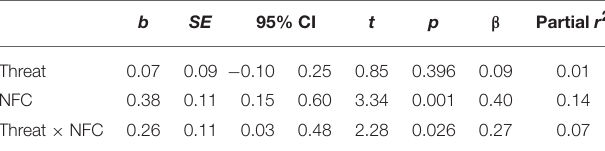
TABLE 1 | Regression statistics for the prediction of cultural novelty avoidance, Study